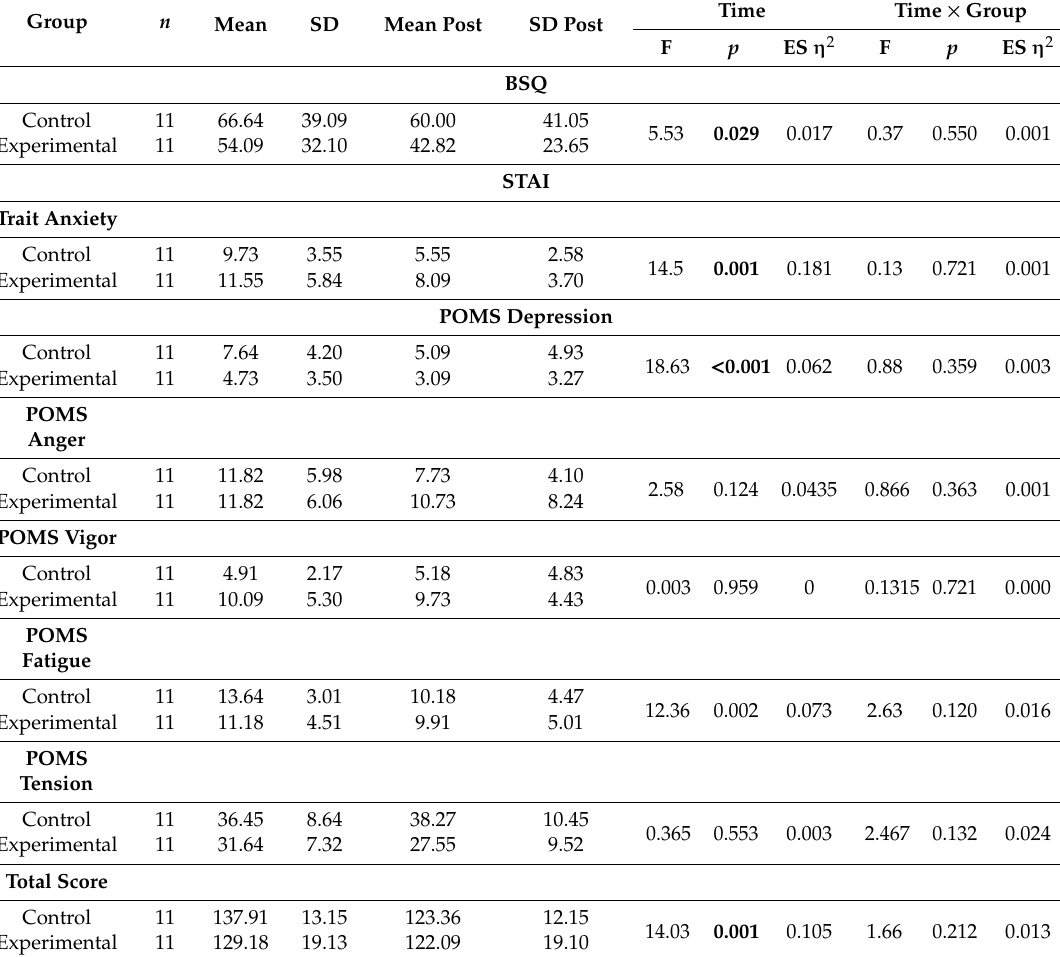
Table 2. Body Shape Questionnaire (BSQ), State–Trait Anxiety Inventory (STAI), Profile of Mood States (POMS), and Eating Attitudes Test-26 (EAT-26) results for control and experimental groups.